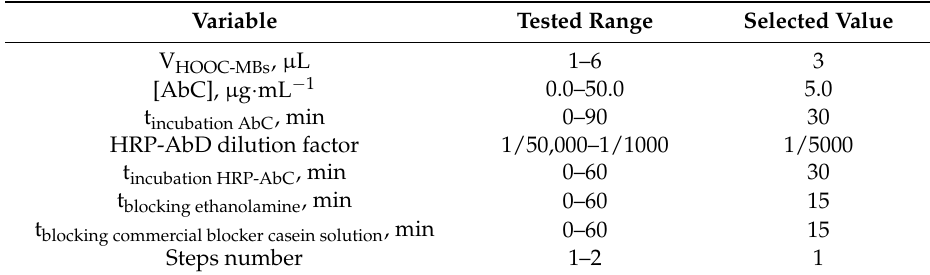
Table 1. Different experimental variables optimized to develop the amperometric human 53 immunosensor.